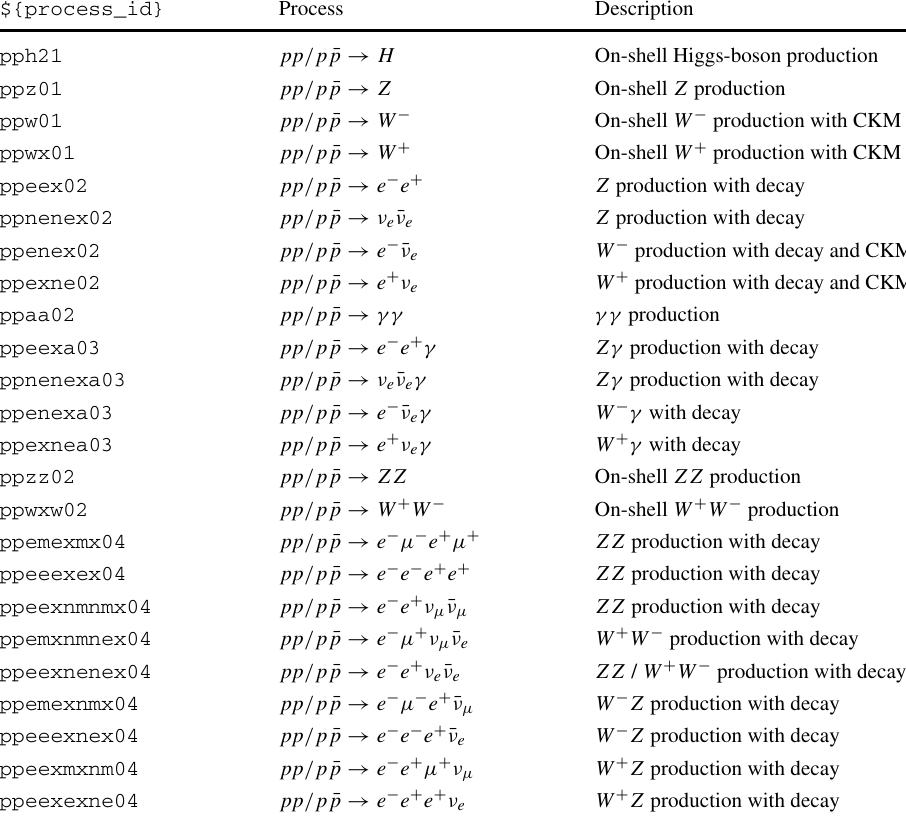
Table 1 Available processes in